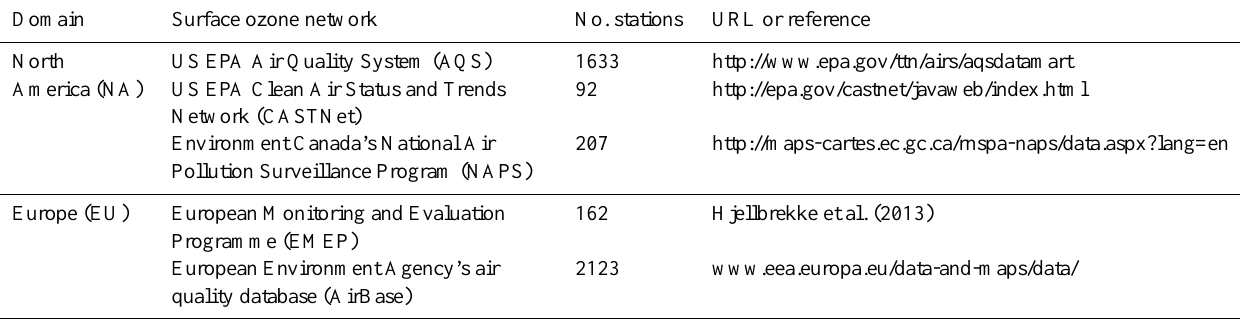
Table 1. Observational data sets (2000 to 2009).